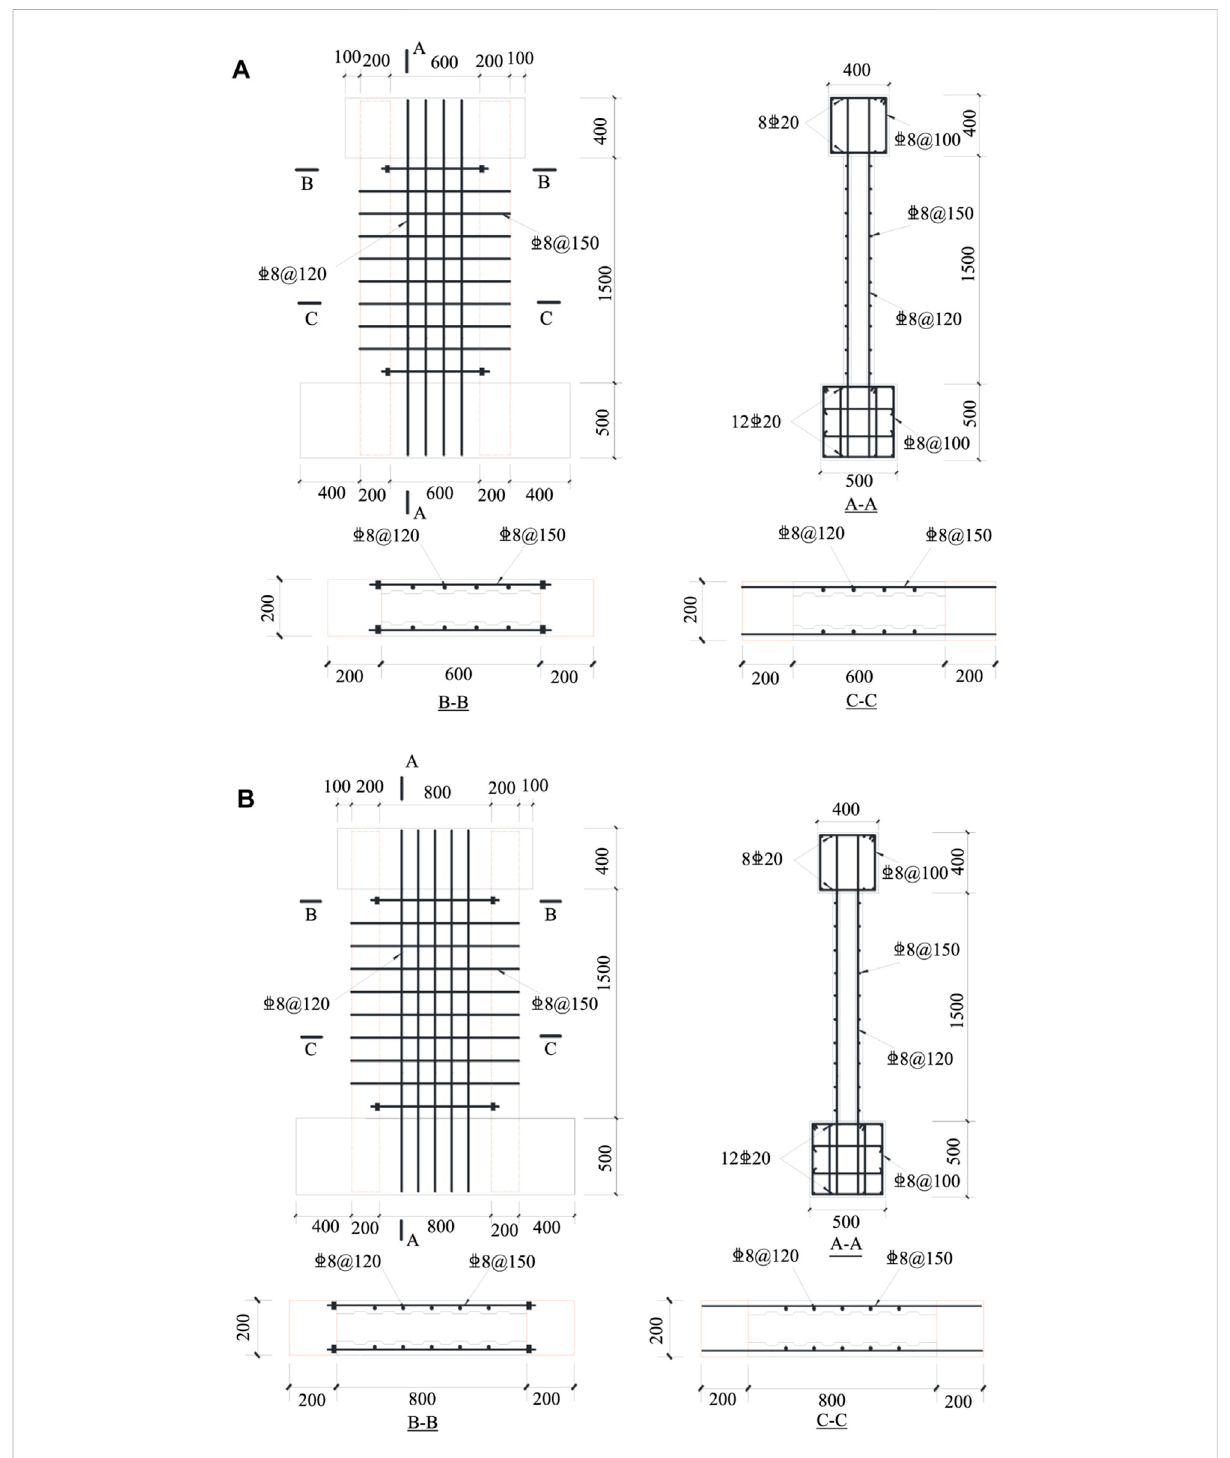
FIGURE 1 Dimensions and details of (A) SW1 and SW2; (B) SW3 (unit: